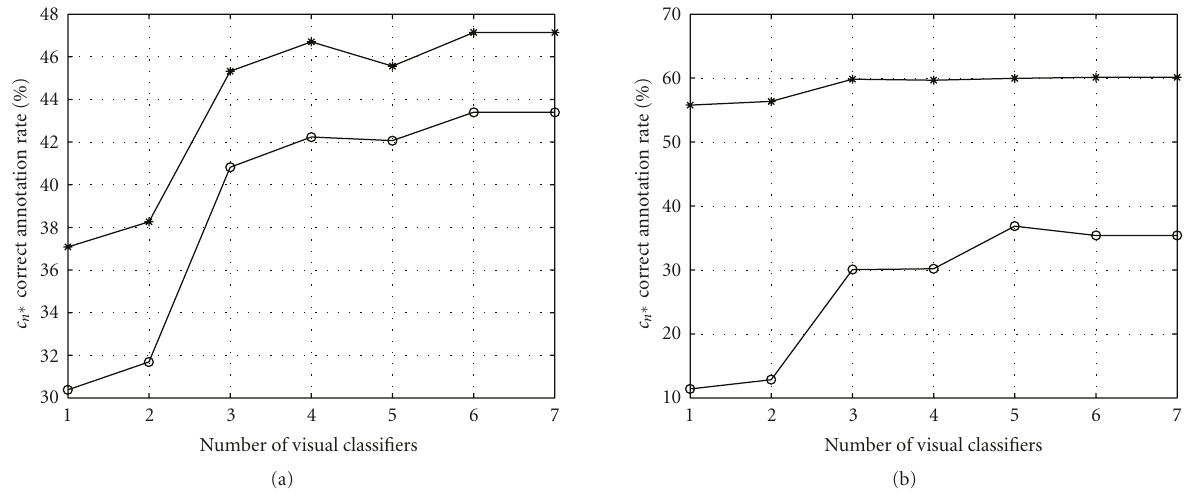
Figure 11: Results of visual classification (“-o-”) and of Generalized Concept Overlay (“- ∗ -”) when the number of visual classifiers (and, consequently, the performance of visual classification) varies, for the datasets used in (a) Table 2 and (b) Table 3.